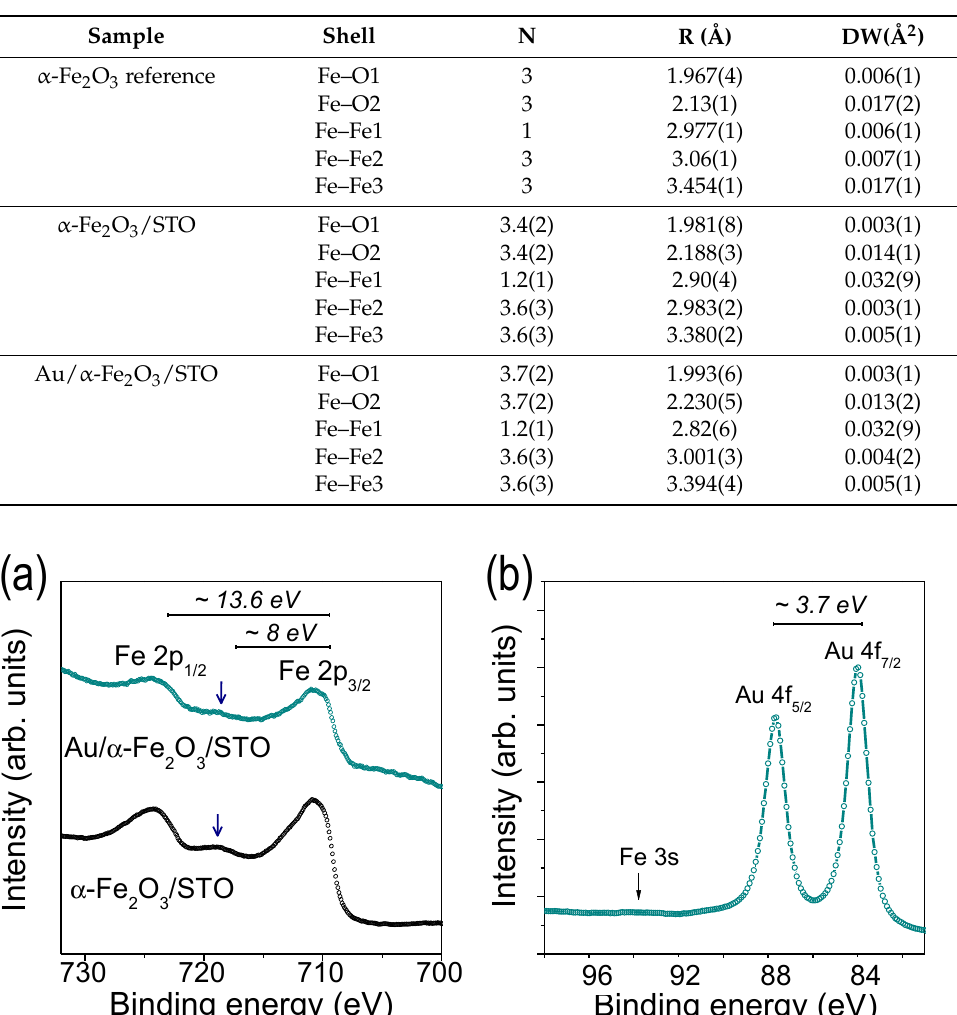
Table 1. Results of the EXAFS fittings by a five-shell model at the Fe K-edge of α -Fe 2 O 3 layer and Au/ α -Fe 2 O 3 bilayer grown on STO(111) substrates. EXAFS parameters are compared with results obtained from powder α -Fe 2 O 3 reference.